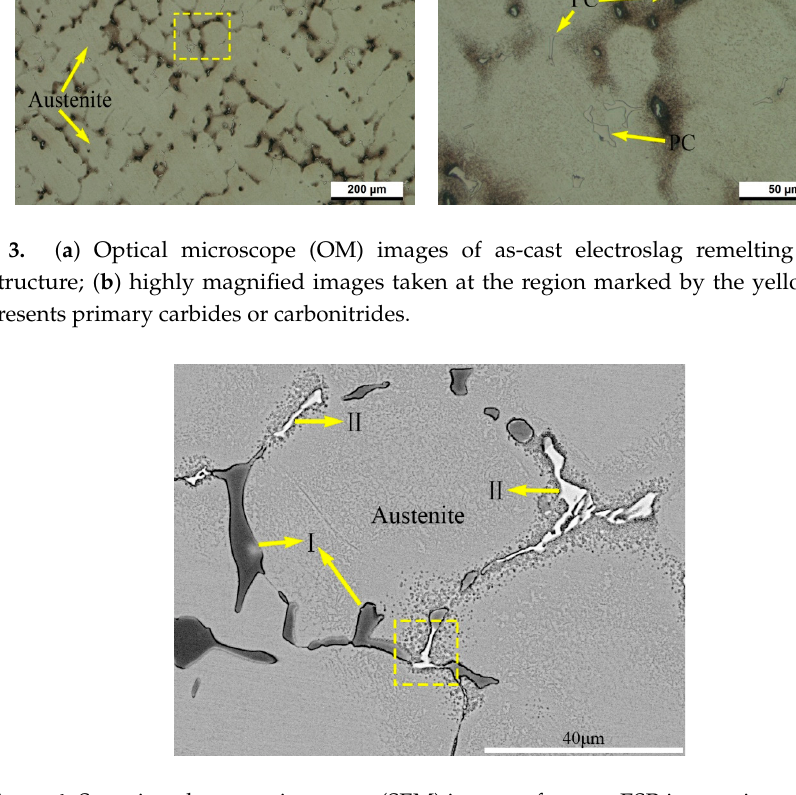
Figure 4. Scanning electron microscopy (SEM) images of as ‐ cast ESR ingot microstructure.